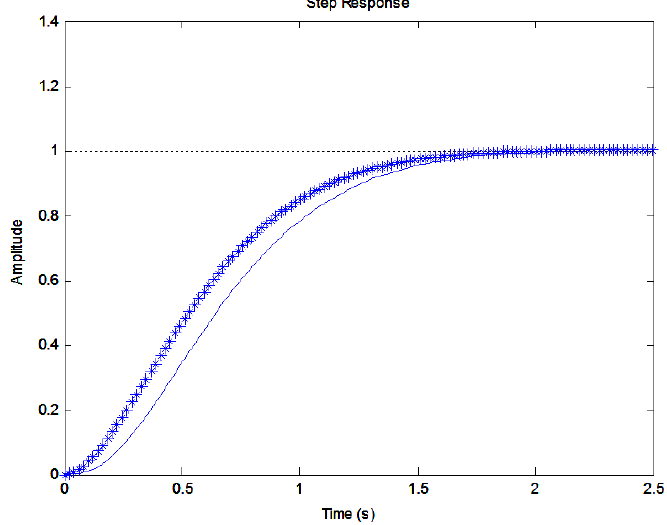
Figure 9. Step responses